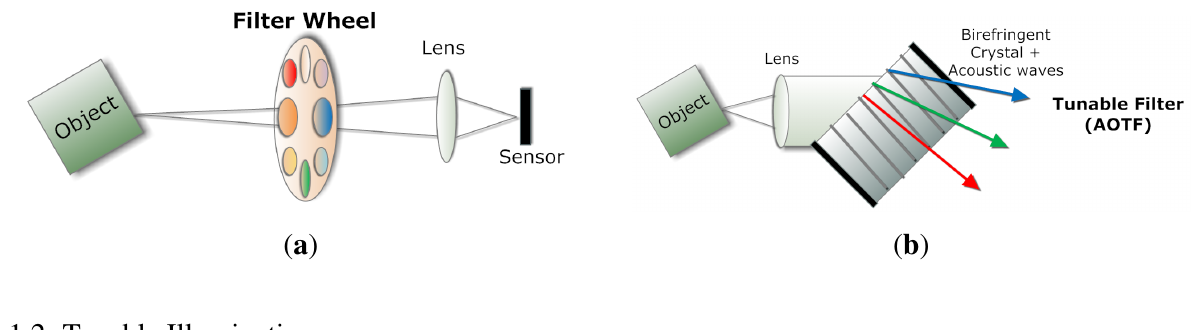
Figure 3. Schemes of the principles used by the techniques of filter wheel and liquid crystal tunable filters (LCTF). ( a ) Filter wheel with optical bandpass filters. Multispectral imaging is recorded by shifting the filters sequentially into the optical path; ( b ) Acousto-optical tunable filter principle. The acousto-optic effect is used to diffract and shift the frequency of light using sound